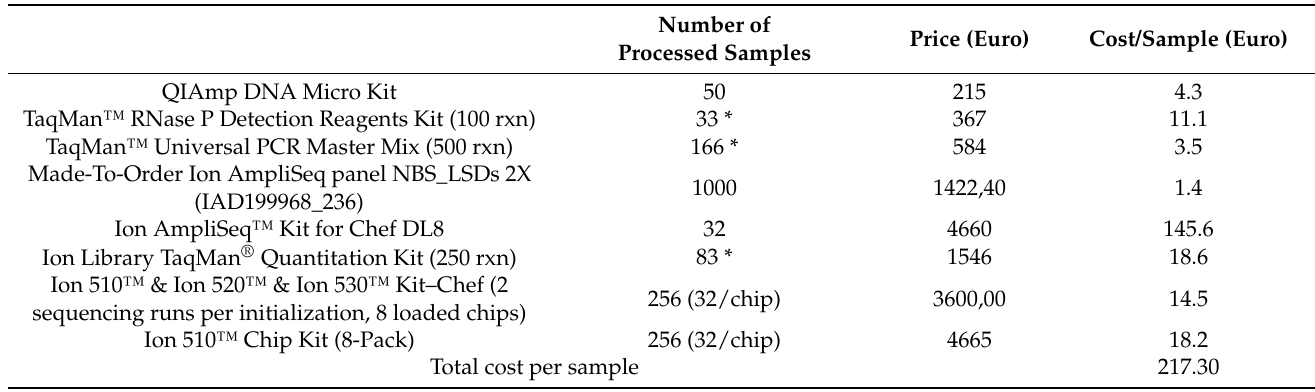
Table 2. Cost per sample (update June 2021) of consumables for semi-automatic sequencing with NBS_LSDs panel.